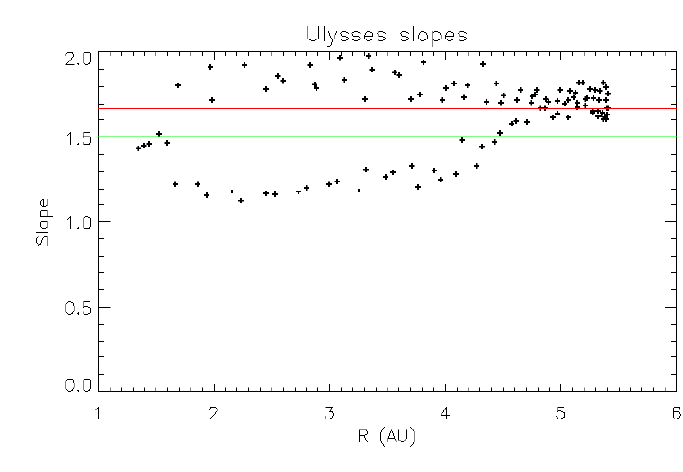
Figure 23: Velocity spectral index vs. heliocentric distance (Roberts,